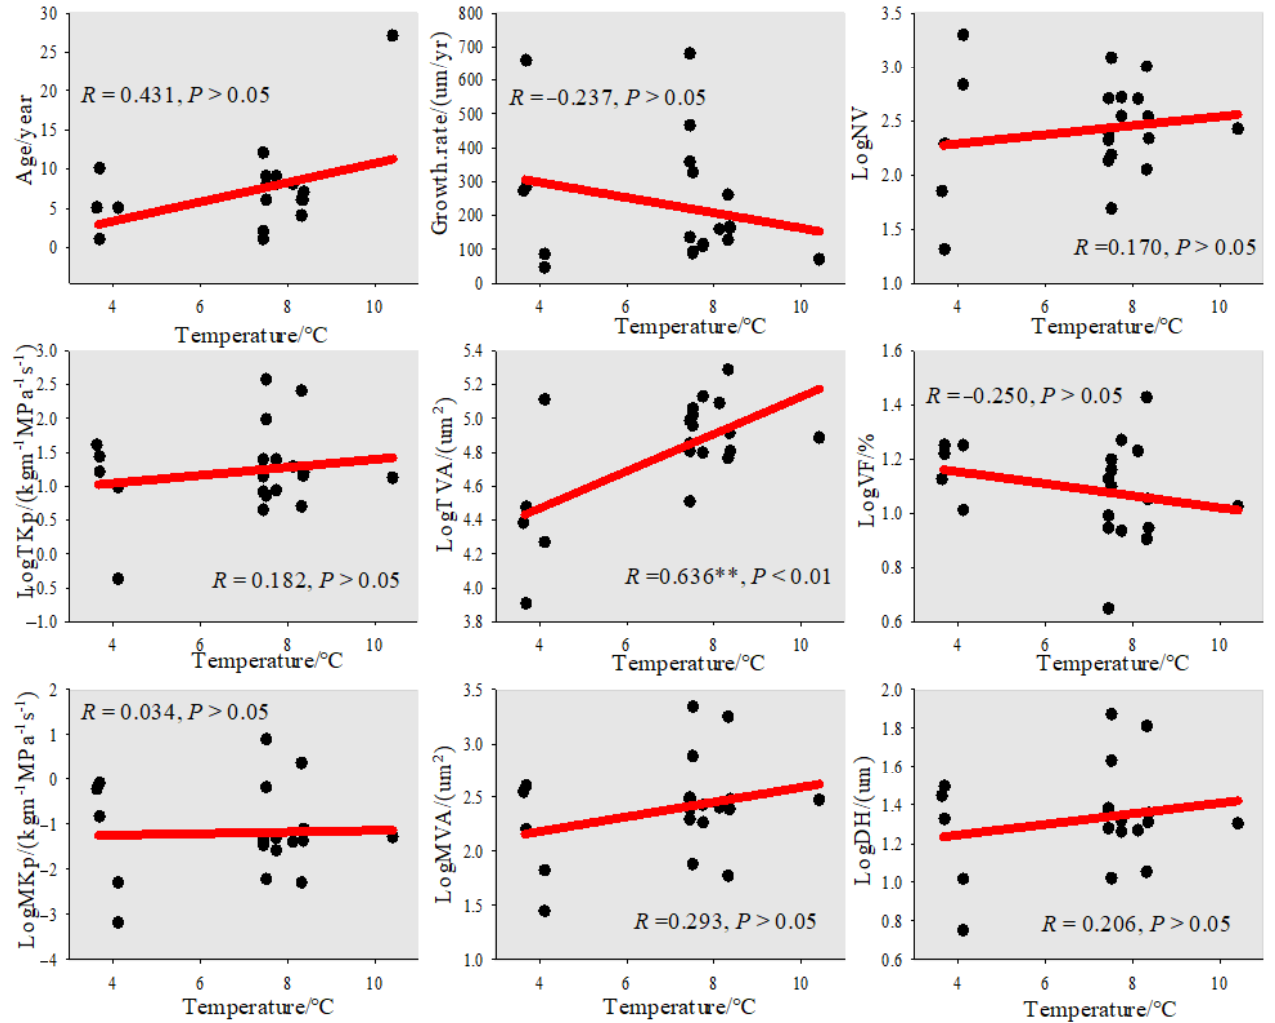
Figure 7. The anatomical characteristics of the root vessels of Zygophyllaceae plants in China’s arid and semi-arid regions change with temperature gradients. Age: (year); Growth.rate: (μm/year); NV: vessel number; VF: vessel fraction (%); TAV: total vessel area ( μm² ); MVA: mean vessel area ( μm² ); TKp: total water transfer efficiency (kg m −1 MPa −1 s −1 ); MKp: mean water transfer efficiency (kg m −1